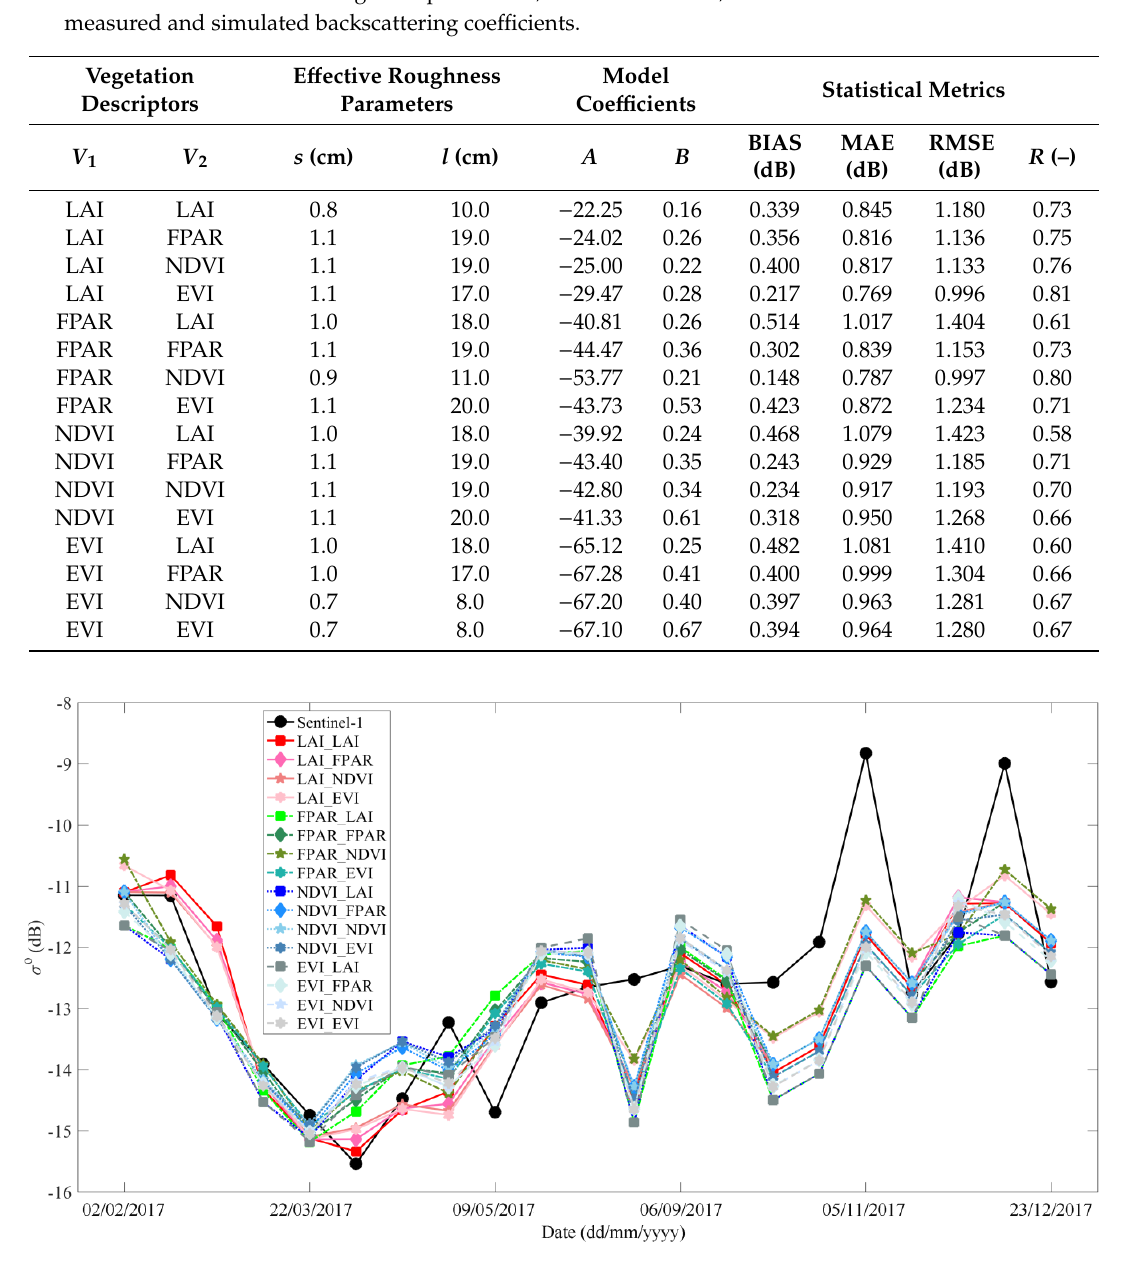
Figure 6. Time series of the Sentinel-1A and simulated backscattering coefficient with different vegetation combinations used for the coupled model. The “LAI_FPAR” indicates that the V 1 and V 2 are characterized by the LAI and FPAR, respectively. Table 2. Selected effective roughness parameters, WCM coefficients, and statistical metrics between the measured and simulated backscattering coefficients.